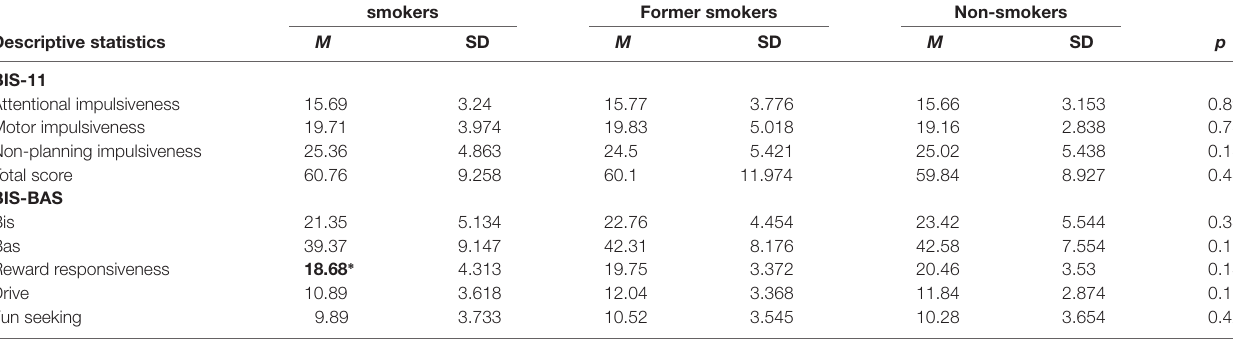
TABLE 2 | Mean values, standard deviations and ANOVA p -values of participants’ impulsiveness and